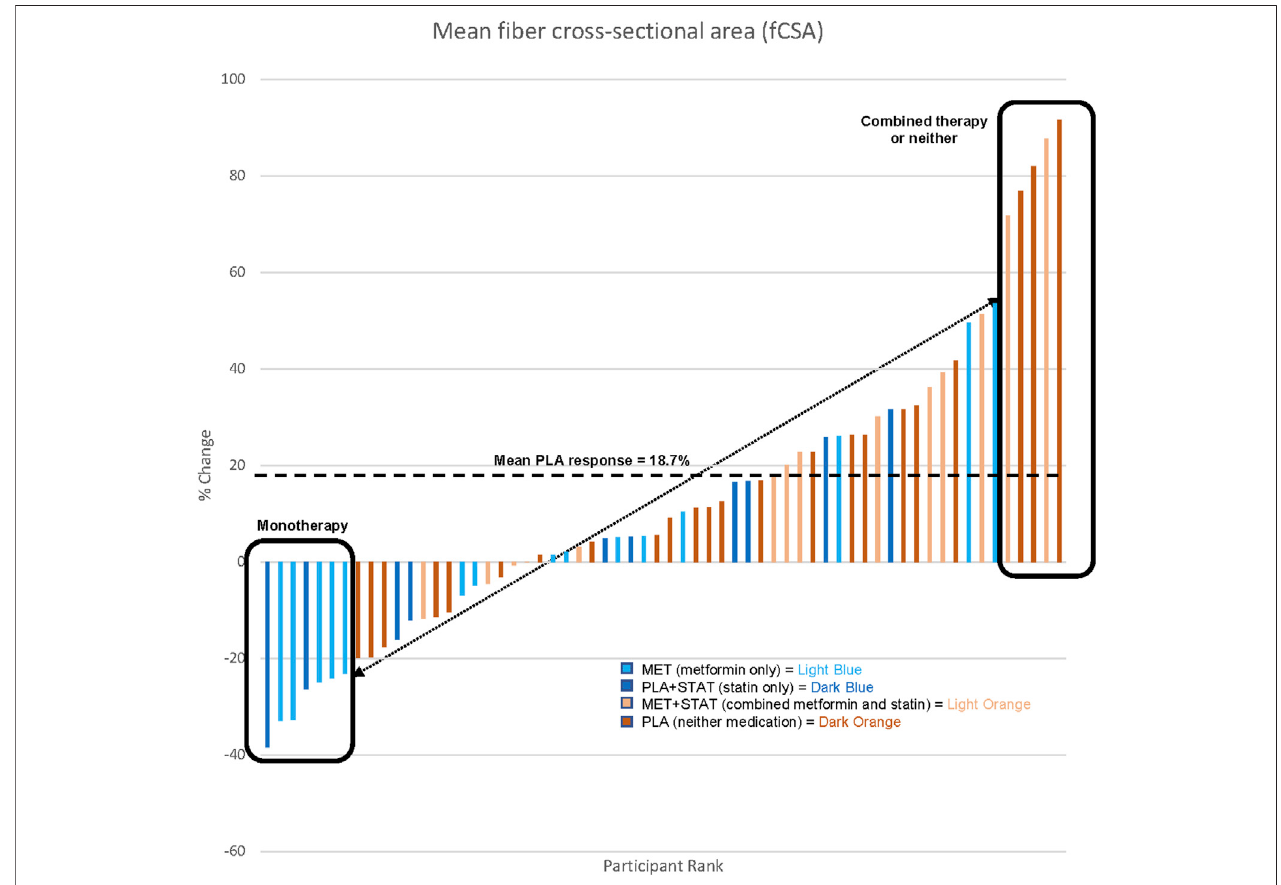
FIGURE3 | Anabolic heterogeneityamoungprescribed stain users (STAT,n-24) versus non-user (n-38) completingthe MASTERD study who were randomized to receviedmetformin(MET)orplacebo(PLA),theaveragepercentchangeinmean fi bercrosssectionarea(FCSA)forPLAparticipatsisshownbythwdottedlineandboxe represent extreme particle responces, FCSA was not determined for samples that were freeze damage or consisted of less than 300 fi bers resulting in a total of n = 62.